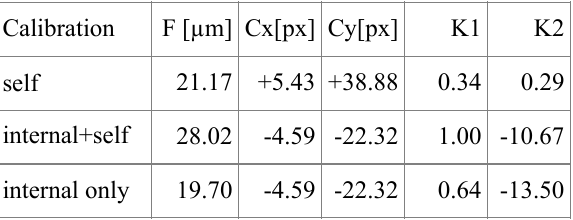
Figure 12: Thermal orthophoto of test site "Rietholzbach". PSP allows the direct orthophoto generation from single channel float images, either from converted TIFF-images or directly from FLIR raw images (extension: .ARA).